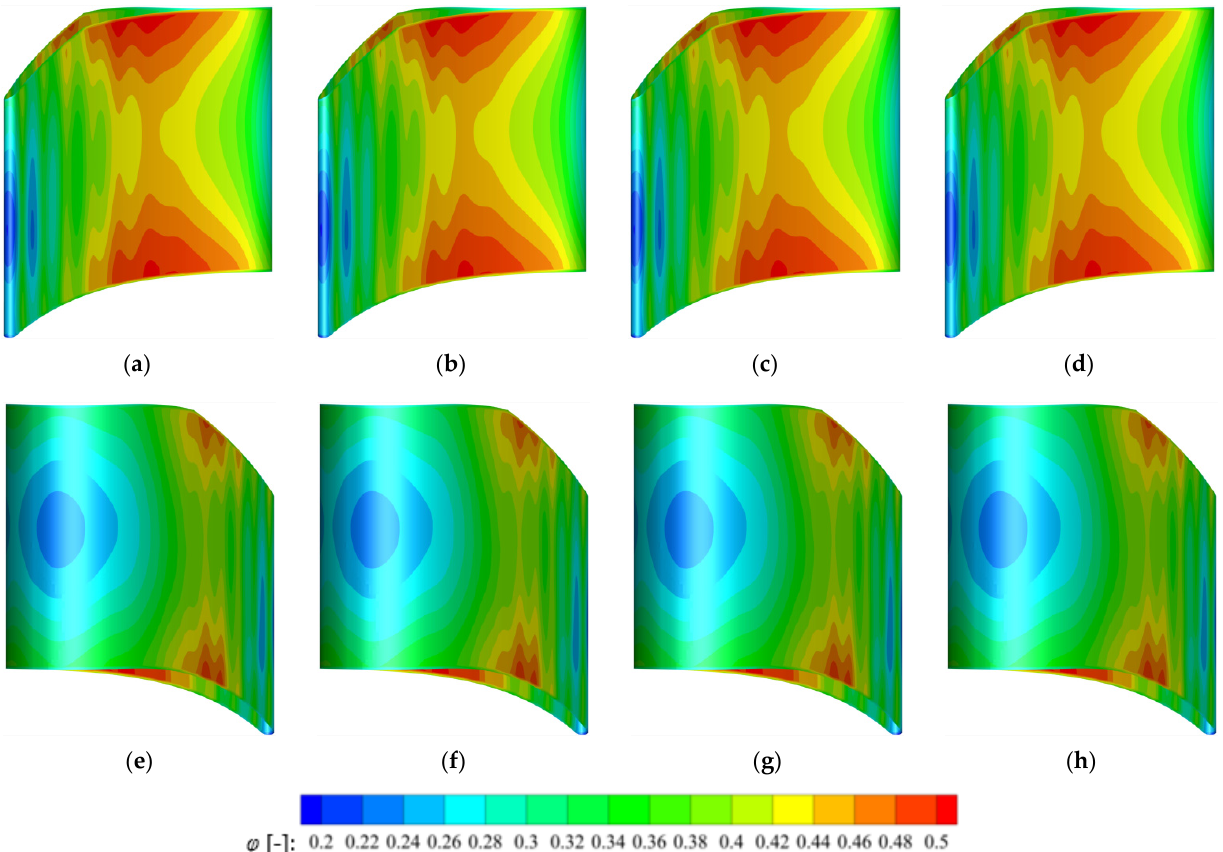
Figure 8. The overall cooling effectiveness of the stator vane at different relative stator–rotor locations. ( a ) Pressure Side At 0/4 T; ( b ) Pressure Side At 1/4 T; ( c ) Pressure Side At 2/4 T; ( d ) Pressure Side At 3/4 T; ( e ) Suction Side At 0/4 T; ( f ) Suction Side At 1/4 T; ( g ) Suction Side At 2/4 T; ( h ) Suction Side At 3/4 T.